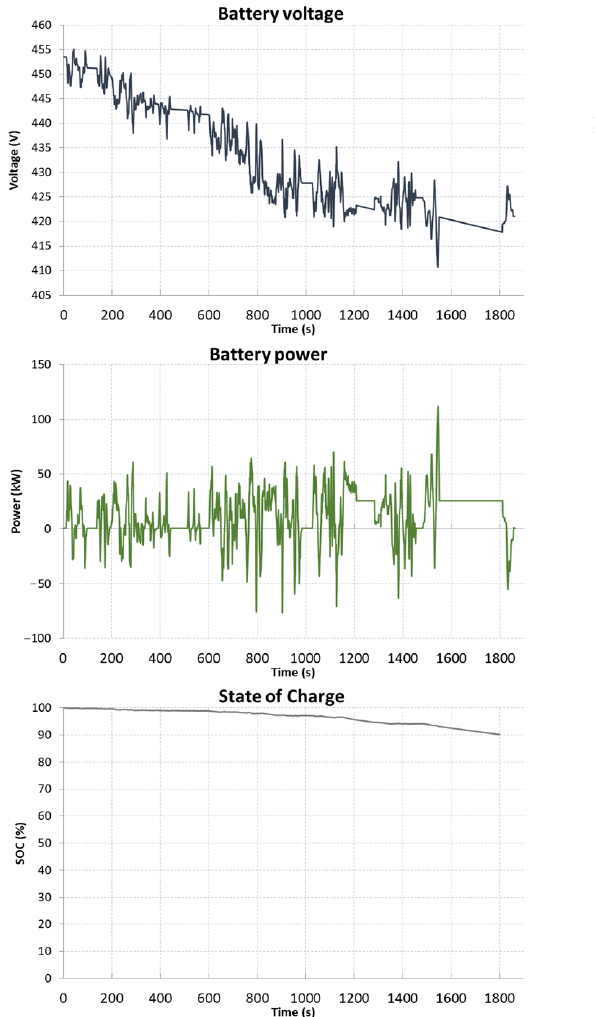
Energies 2022 , 15 , 9613 15 of 28